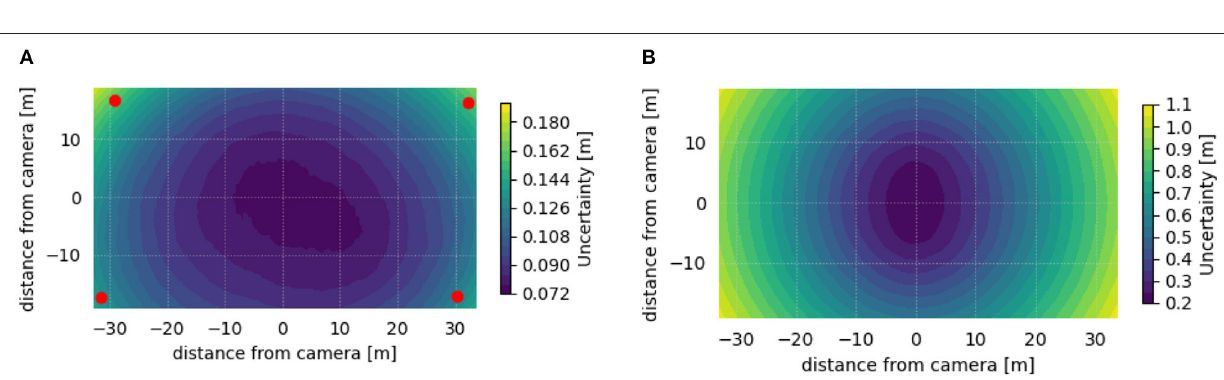
inaccurate GCP pixel coordinates during the extrinsic